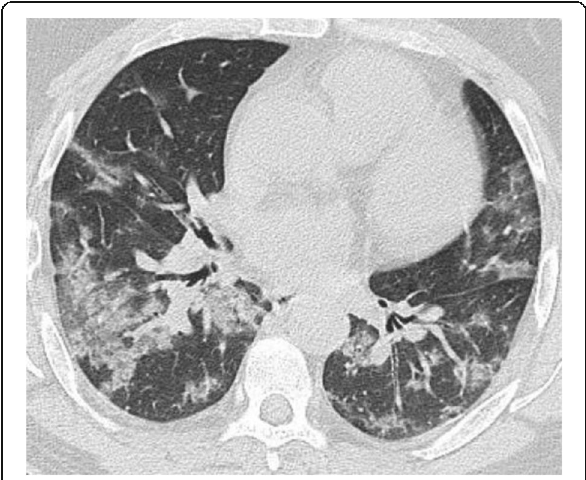
Fig. 10 Patient with advanced COVID-19 and crazy paving appearance